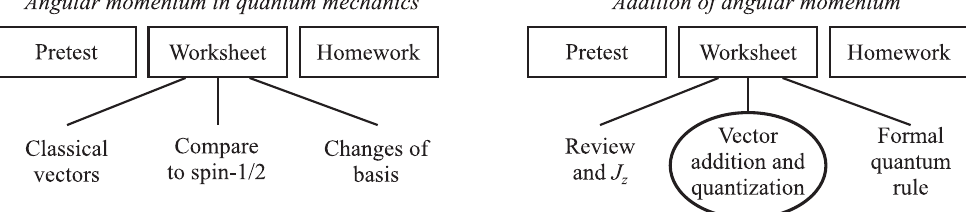
FIG. 4. The sequence of activities associated with the angular momentum tutorials. Each tutorial consists of a pretest, worksheet, and homework assignment, all given after lecture instruction on the corresponding topic. Each worksheet is further divided into three activities — in this article, we describe the vector addition and quantization activity in